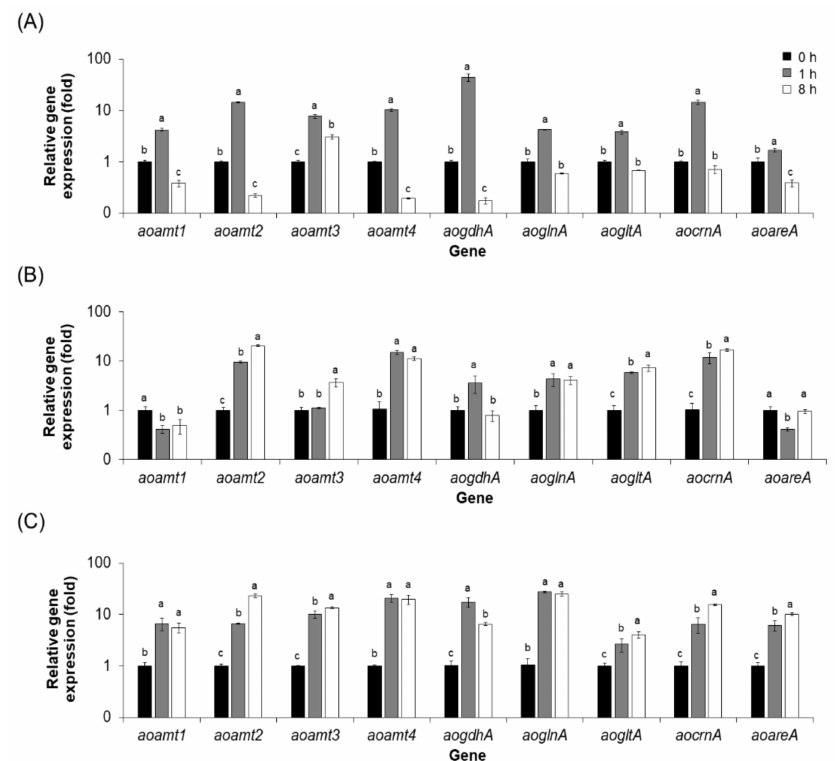
Figure 7. Transcriptional analysis of a set of genes in the overexpressed strains at different time points of cultivation. Expression analysis of aoamt1–4 , aogdhA , aoglnA , aogltA , aocrnA , and aoareA genes in the AoT16 ( A ), oeaoamt2 ( B ) and oeaoamt3 ( C ) cultures grown in 1 mM NH 4 Cl-containing medium was carried out by RT-qPCR. RNA samples were extracted from the cultures after transferring to a 1 mM NH 4 Cl-containing medium for 0, 1, and 8 h. The expression level of each gene at 0 h (black bars) was adjusted to 1. Different letters (a, b, and c) above the bars indicate a statistically significant difference in the transcript levels of each gene at various time points analyzed by Duncan’s multiple range test (MRT) ( p value < 0.05). The mean standard deviation (mean SD) of relative expression ± ± level is derived from triplicate